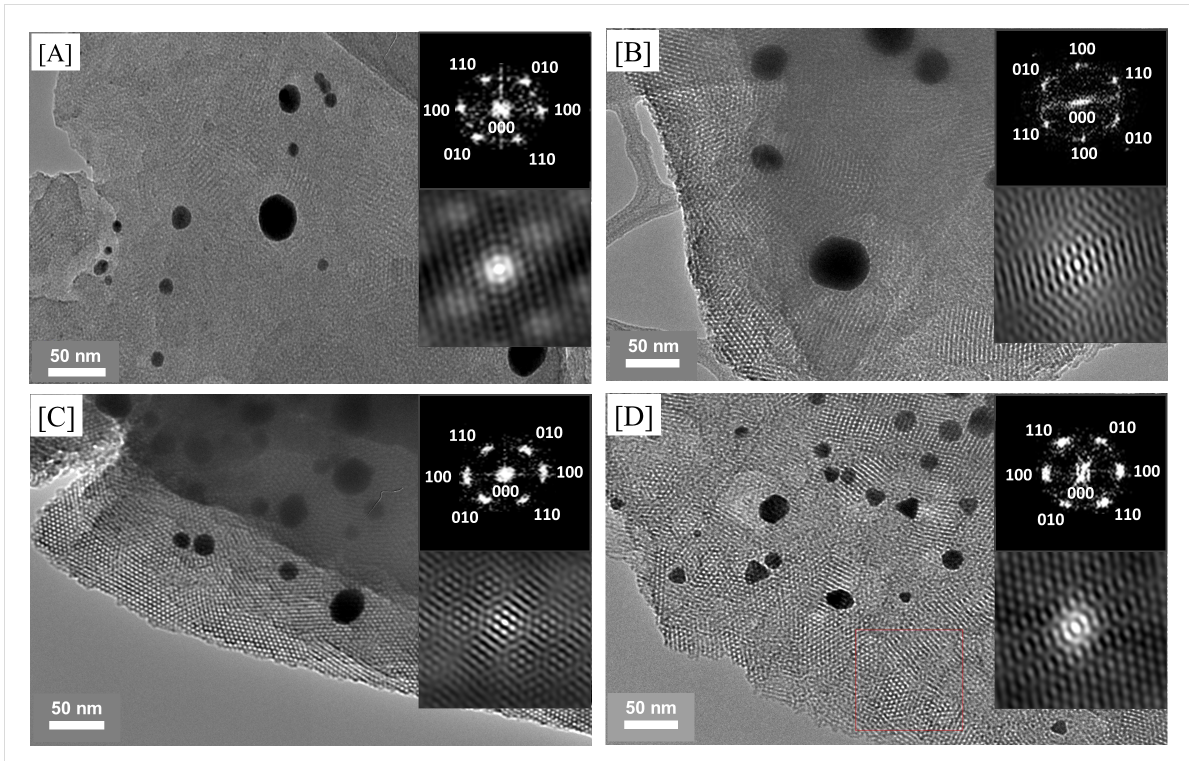
Figure 5: TEM images of a) [AuNPs] cal /silica hex films at 250 and b) 450 °C and as well as c) [AuNPs] red /silica hex films at 210 and d) 250 °C. The insets show the corresponding FFT (top) and auto-correlation images (bottom).